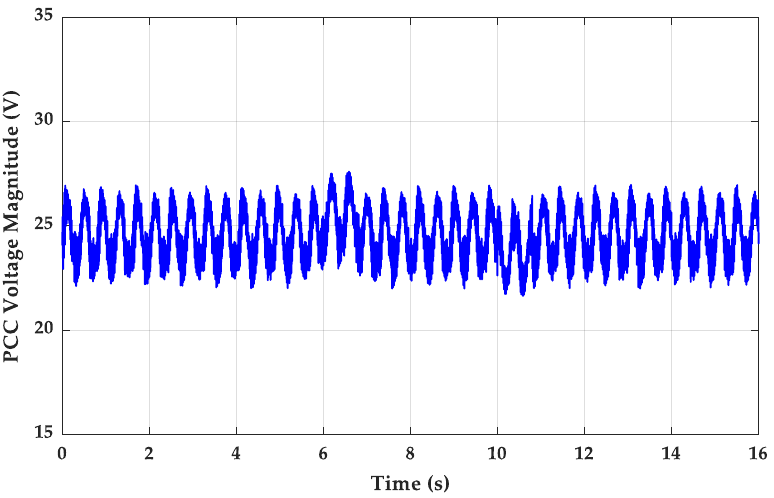
Figure 12. PCC voltage magnitude (Experiment 1).